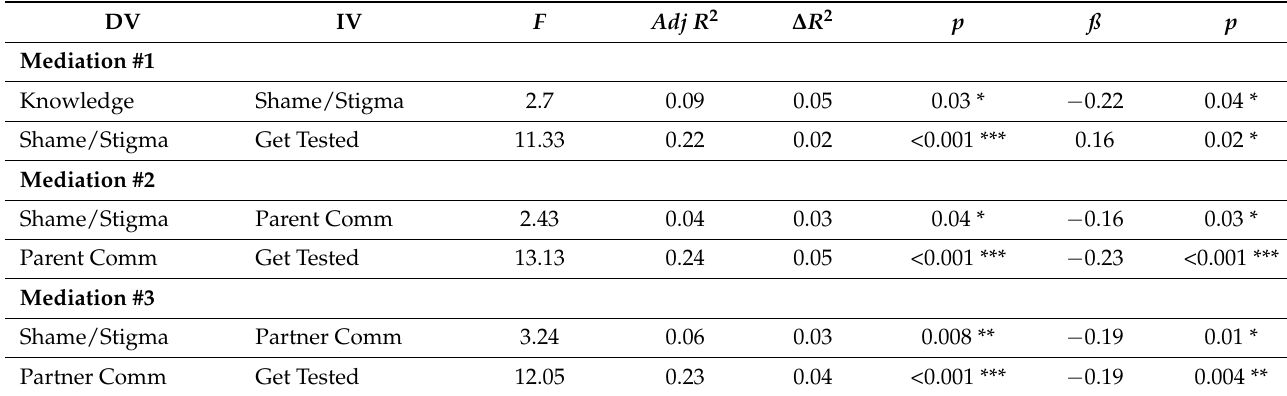
Table 3. Multiple Regressions between